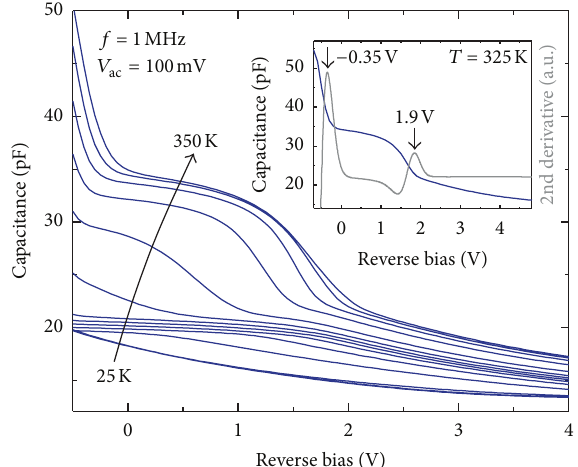
Figure 1: C-V scans for temperatures between 25 K and 350 K in steps of 25K. The evolving plateau due to the emission and capture processes of the QDs is clearly visible. Above 300K all hole states in the QD ensemble contribute to the total capacitance. The voltages at which the QDs enter and leave the depletion region can be seen in the second derivative of the C-V curves (see inset).